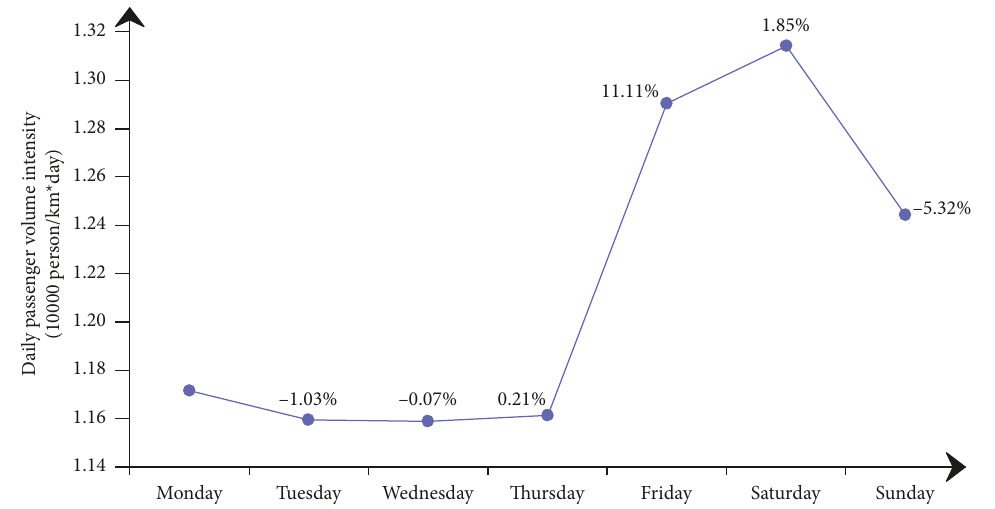
Figure 5: The daily passenger volume intensity on weekdays and